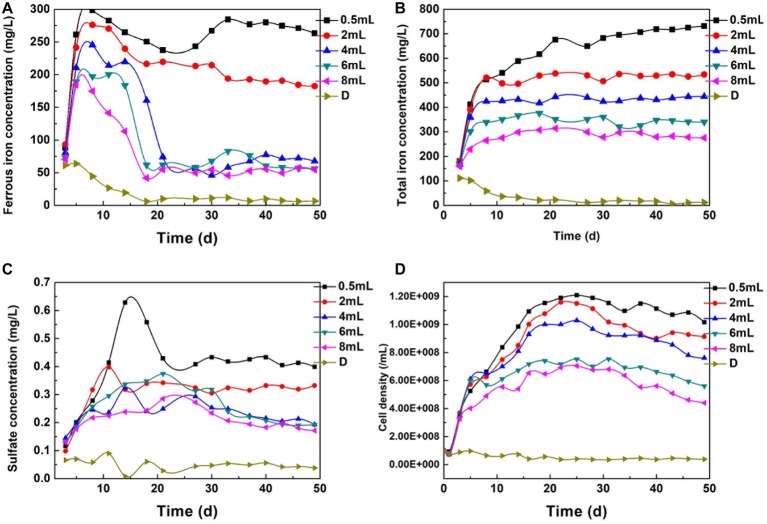
The Change of Fe(II) (A), TFe (B), SO42−
(C), and bacterial density (D) under different dosage.